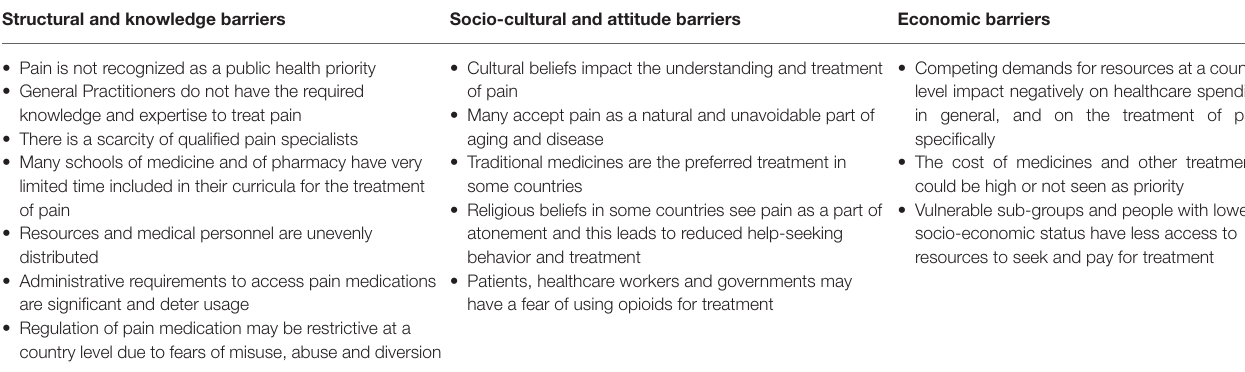
TABLE 1 | Barriers to the optimal treatment of pain in developing countries